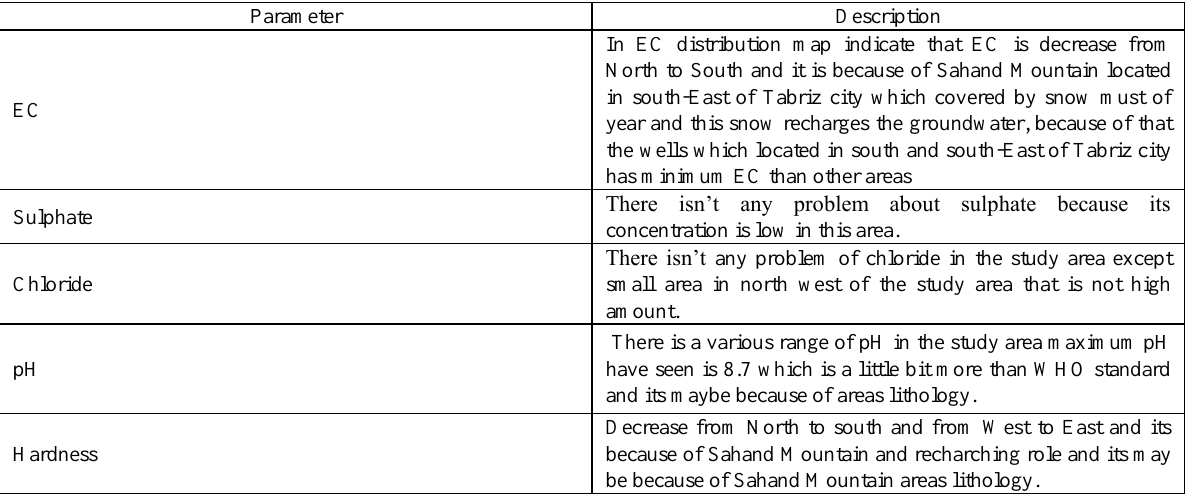
Table 6. The spatial distribution and evaluation of water quality